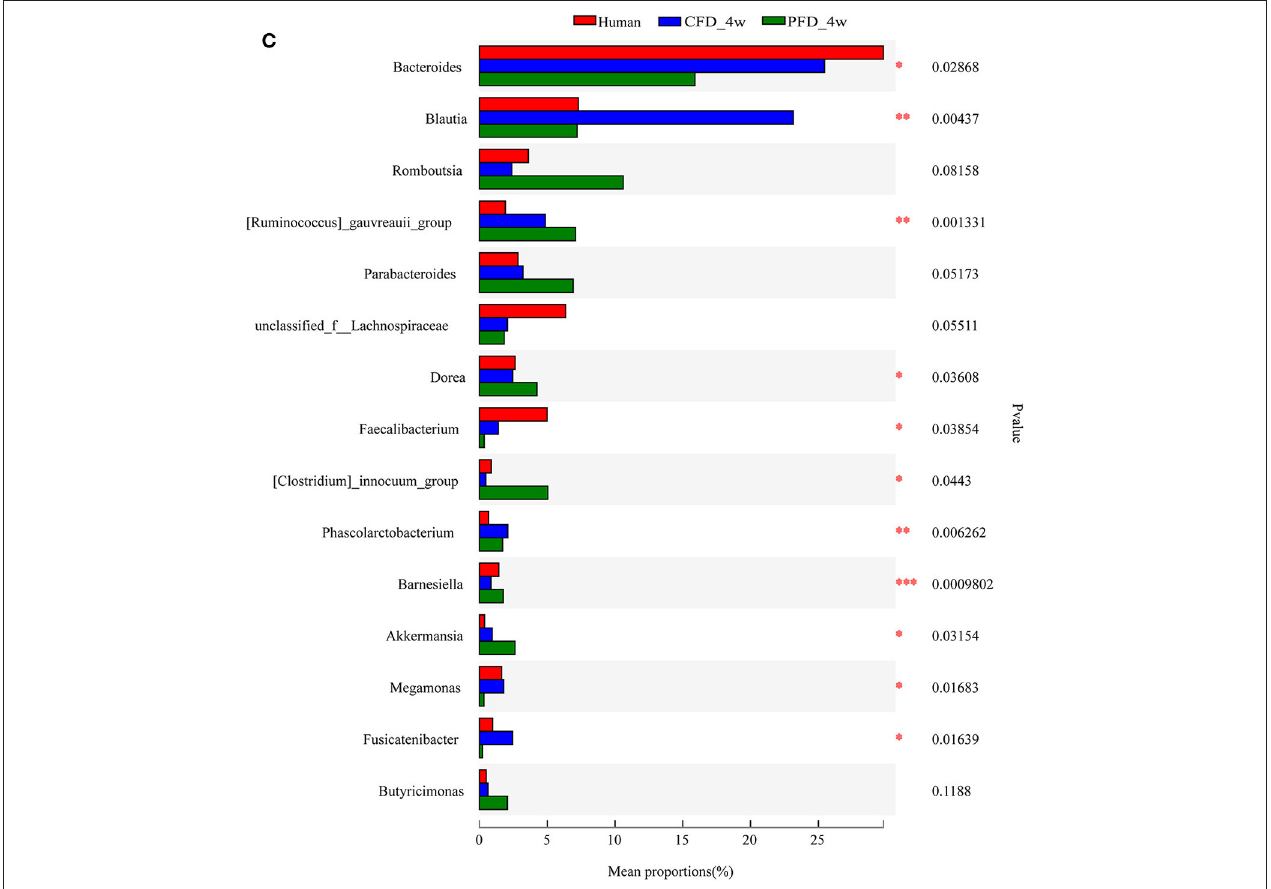
FIGURE 6 | Mean proportions of the different genus at 1, 2, and 4 weeks. The one-way ANOVA test was used to evaluate the discrepancy of comparisons within three groups. * p < 0.05, ** p < 0.01, *** p < 0.001.